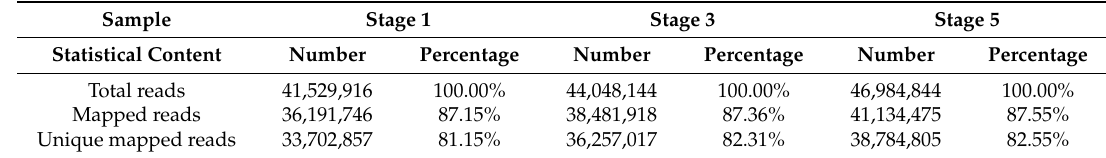
Table 3. Alignment statistics of MBSes for three phases.